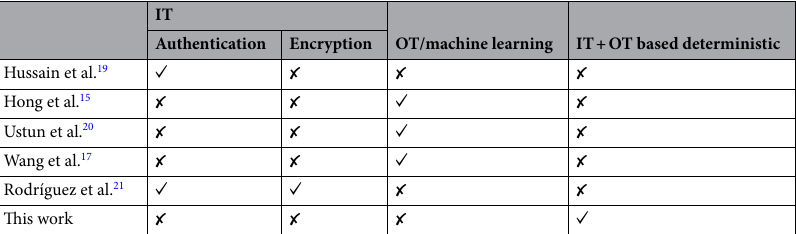
Table 1. Cybersecurity solutions for securing GOOSE